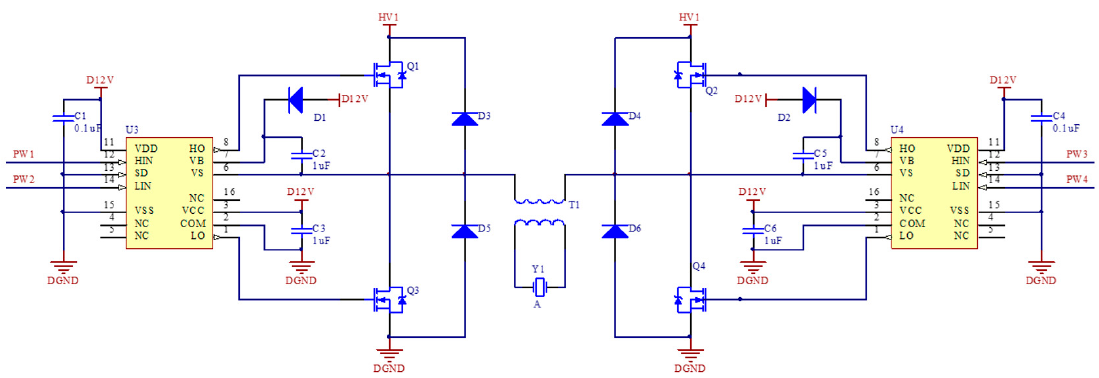
Figure 6. Core electronic structure of full bridge SPWM circuit.